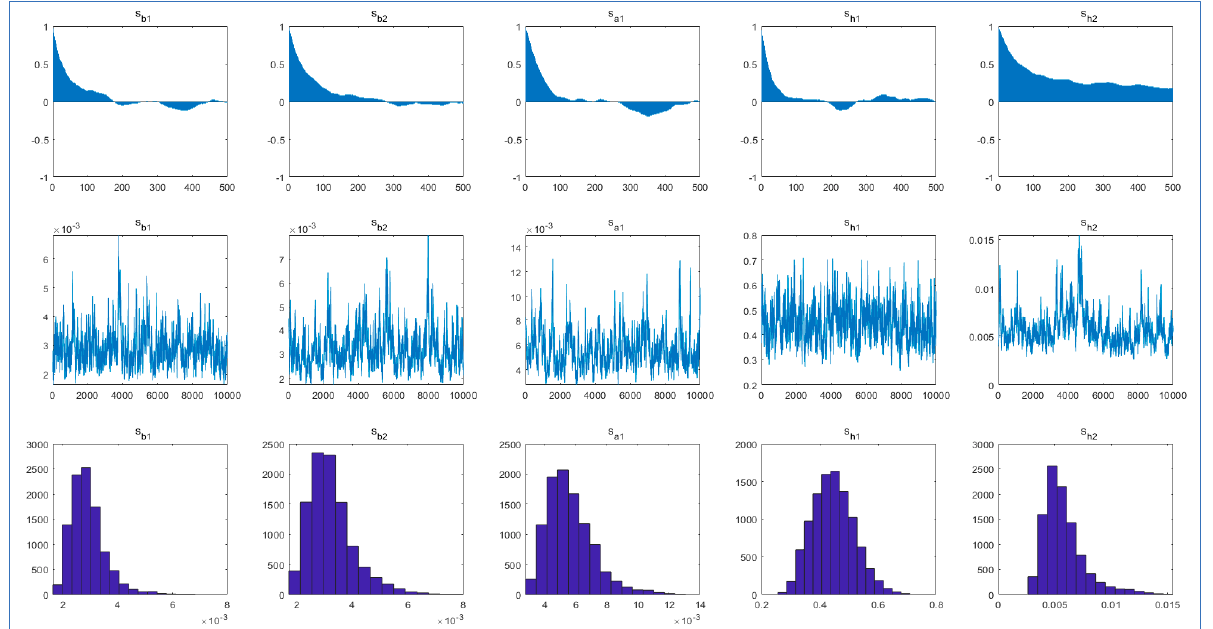
Figure 5. Post-distribution of Gibbs sampling (based on KB Price Index). Note: the first line graph shows the autocorrelation; the second shows the sample path; and the third shows the posterior distribution density. Source: estimated by authors with the TVP-VAR model.